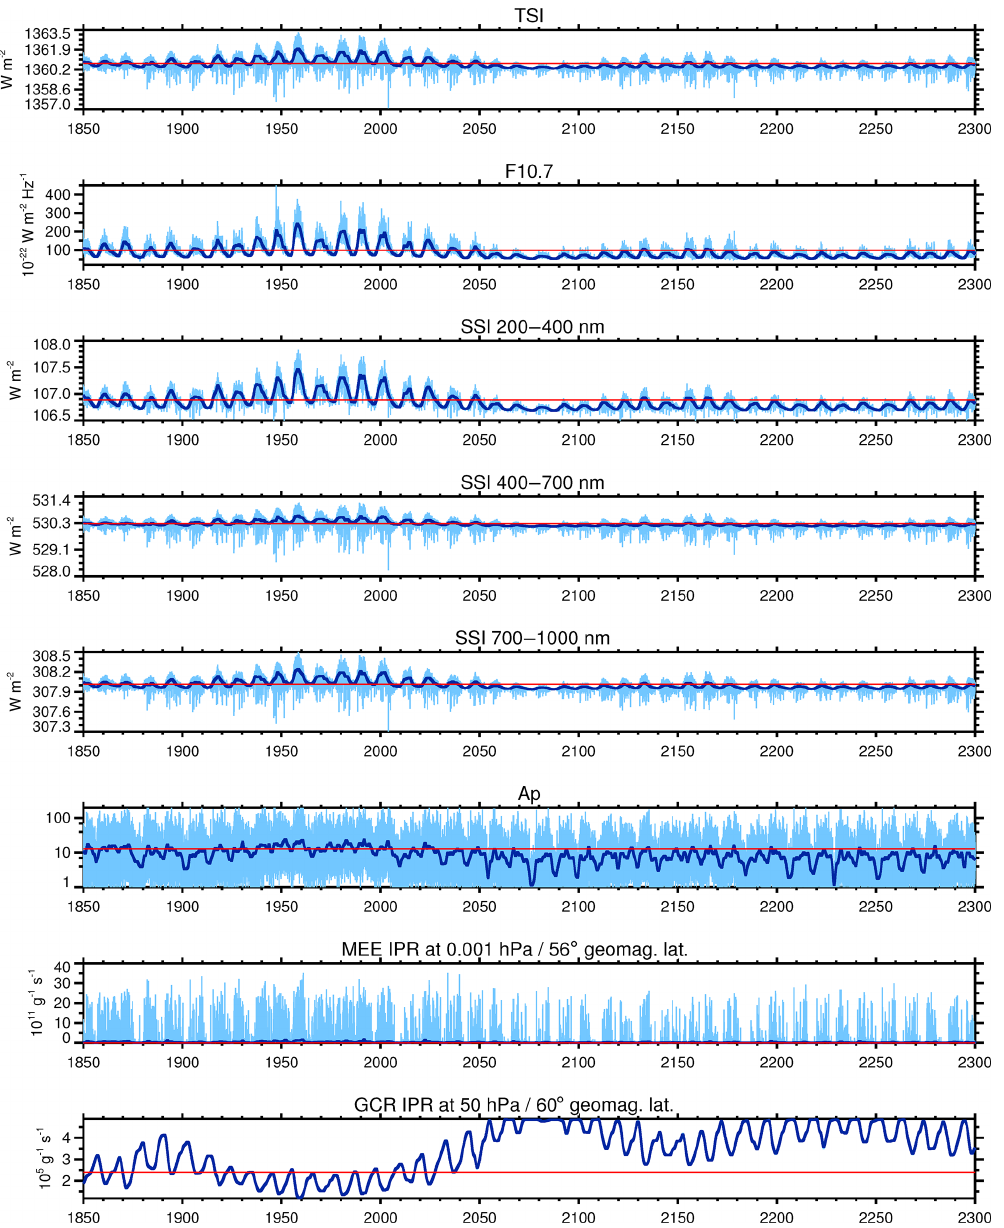
Figure 25. CMIP6 deep minimum (EXT) scenario forcing shown for (from top to bottom) TSI, F10.7, SSI at 200–400nm, SSI at 400– 700nm, SSI at 700–1000nm, Ap, MEE IPR at 0.001hPa and 56 ◦ geomagnetic latitude, and GCR IPR 50hPa and 60 ◦ geomagnetic latitude. Annually smoothed values are shown by dark blue lines. Constant values of the PI control forcing (see Sect. 4) are shown with red lines as